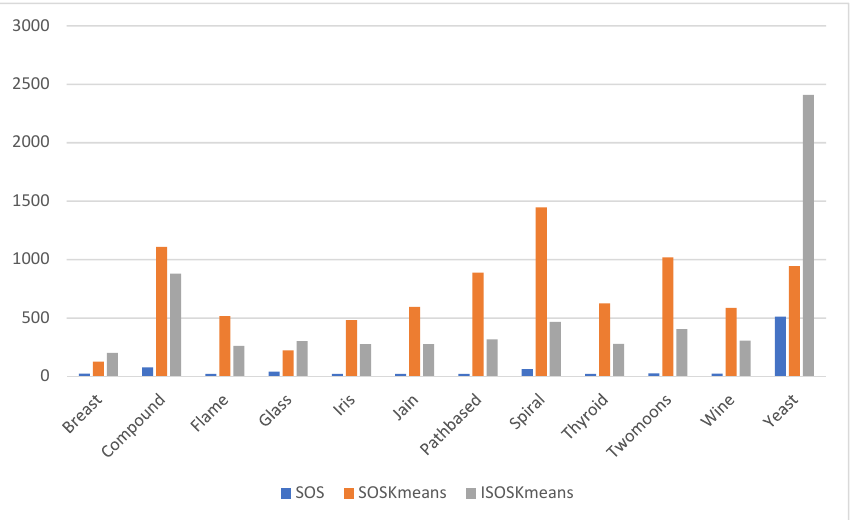
Figure 6. Analysis of computational times of SOS, SOSK-means and ISOSK-means under the DB